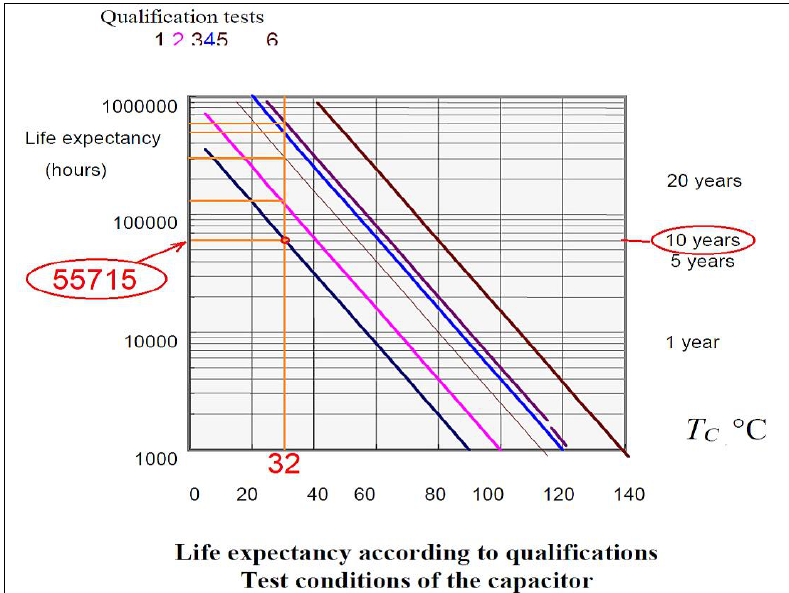
Figure 4. Life expectancy calculation based on excerpt from TR62380 standard for aluminum electrolytic non-solid electrolyte capacitor. A capsule temperature of 32 °C results in a lifetime of 60,000 h (55,715 from formula by calculation) or about 10 years (redrawn from IEC TR 62380 standard [17]).